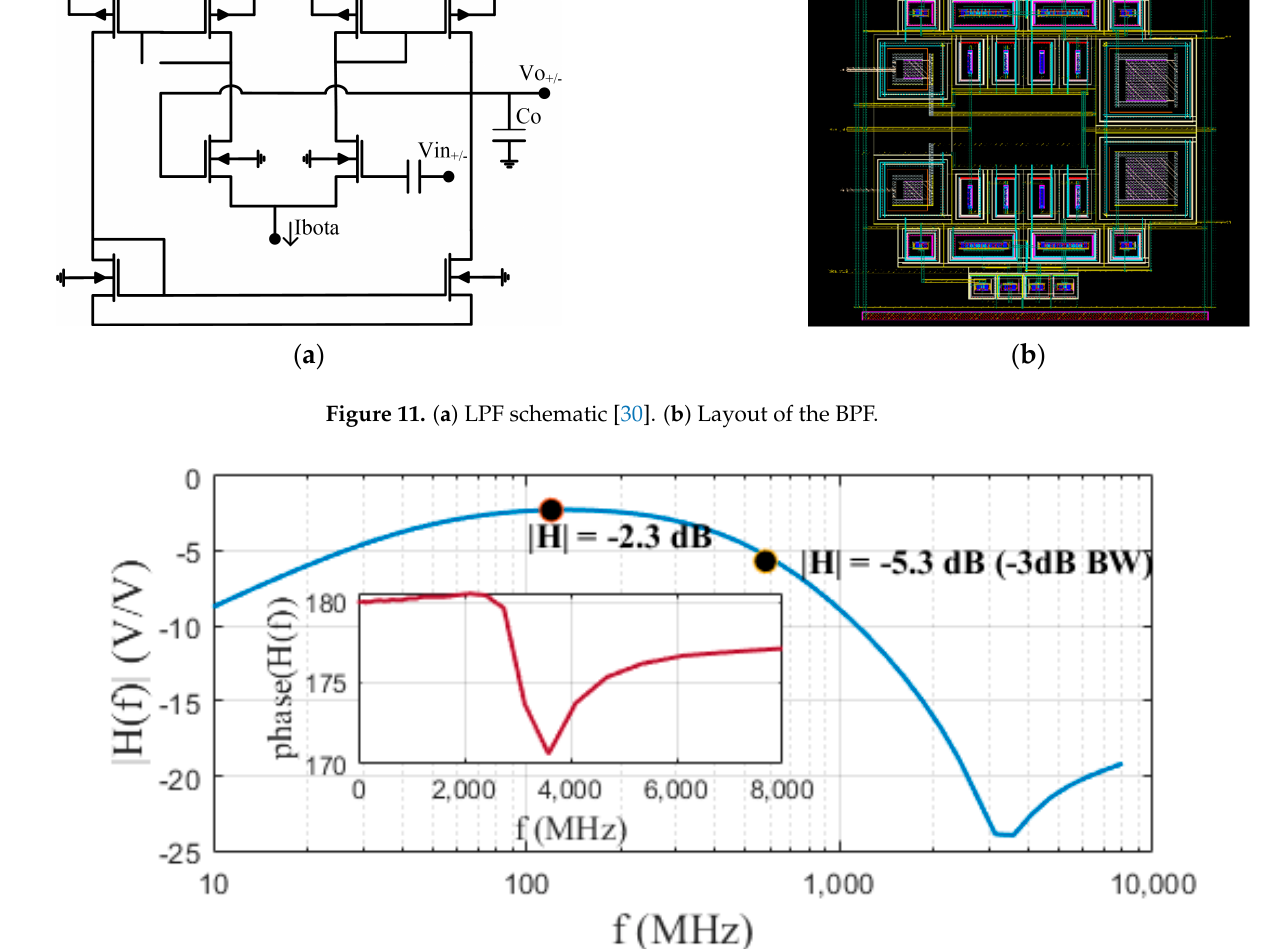
Figure 12. Low-pass filter transfer function: Magnitude (blue) and phase (inset).